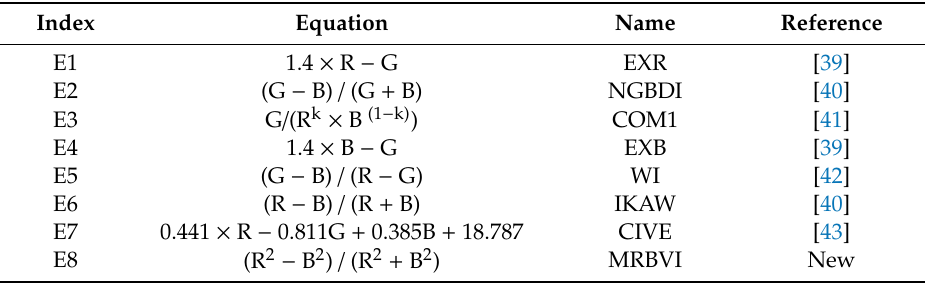
Table 2. The commonly used vegetation indices (VIs) and proposed modified red blue VI (MRBVI). Note: E stands for equation and the value k = 0.667; and E8 is the